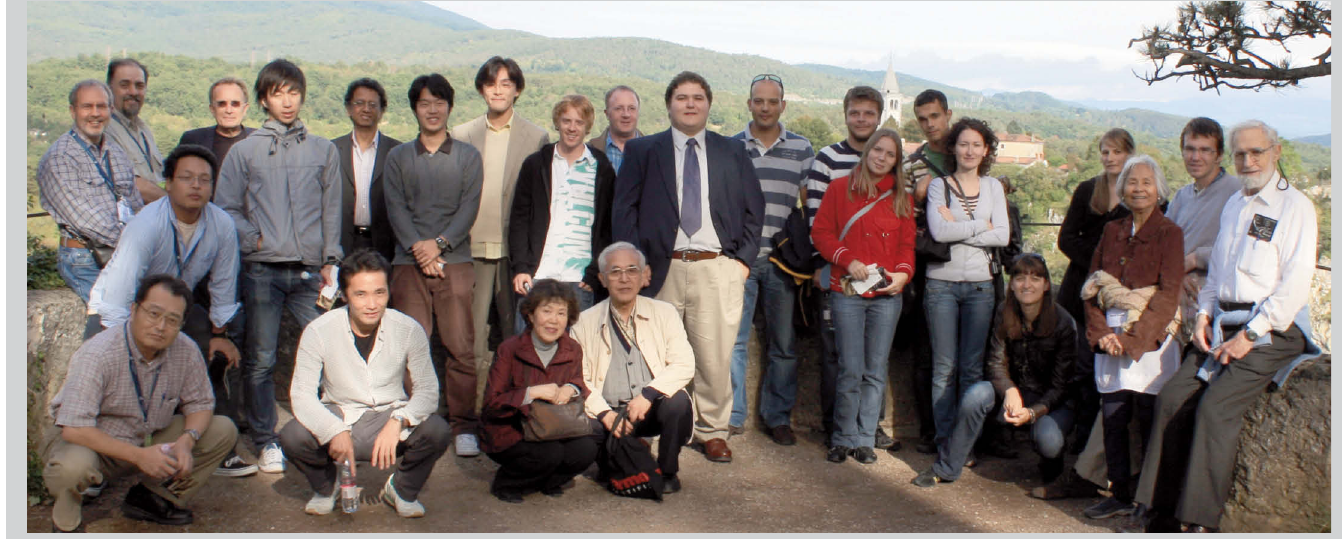
Figure 2: Participants of the MTDM’2010 Conference at the viewpoint to the Big Valley near Skocianska